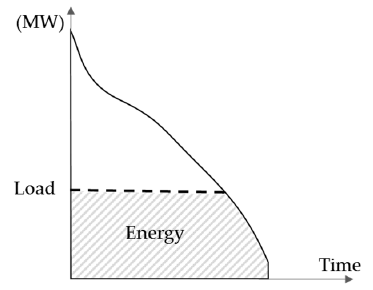
Figure 2. Illustrative LDC.